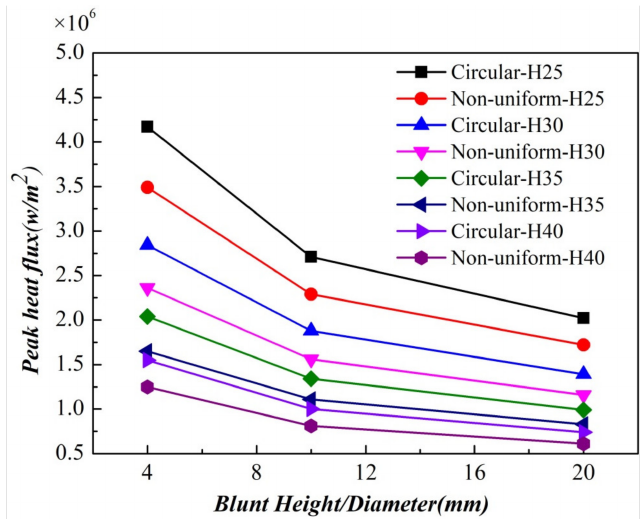
Figure 17. Comparison of peak heat flux for various flight altitudes.